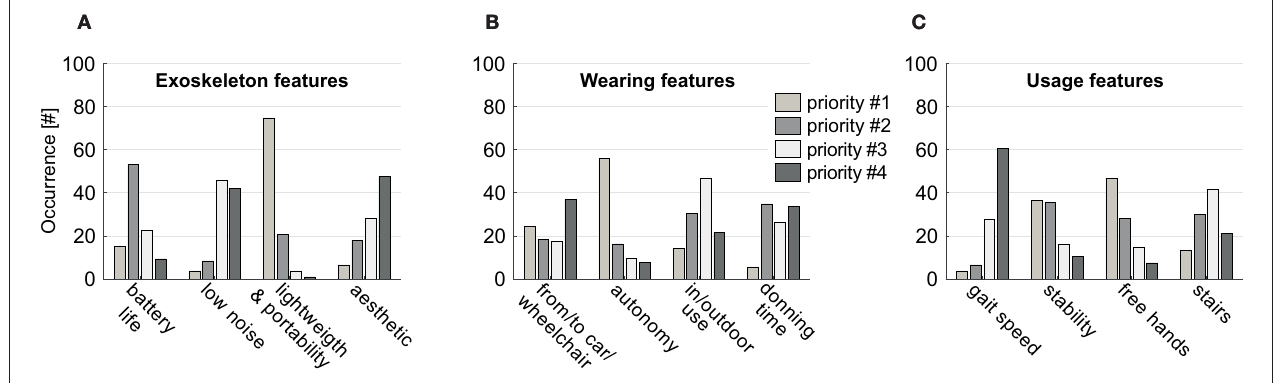
FIGURE 2 | Questionnaire outcomes. Perceived priorities for: (A) exoskeleton features, (B) exoskeleton wearing, (C) exoskeleton use. Histograms represent the number of subjects indicating the features reported in the abscissa as top priority (light gray bars), second priority (gray bars), third priority (white bars), or fourth priority (dark gray